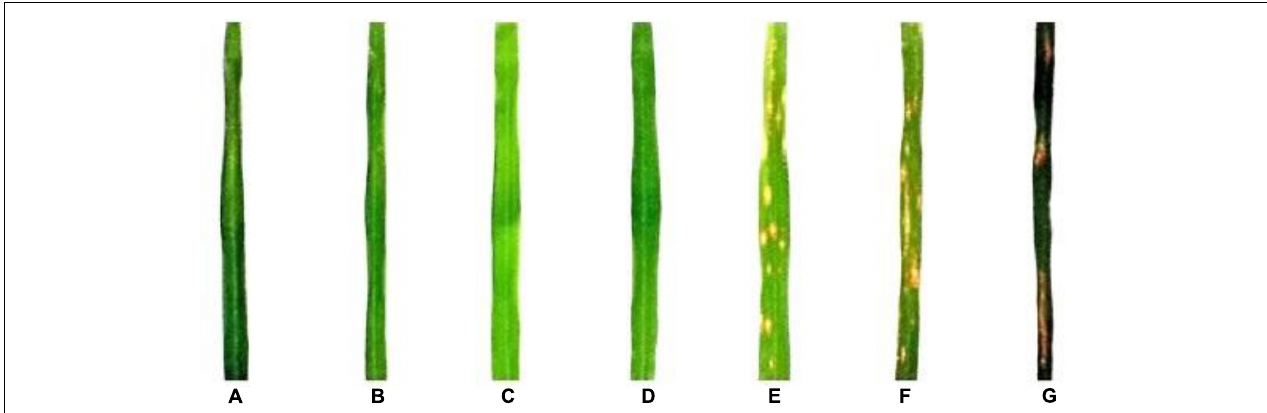
FIGURE 1 | Pathogenicity assay of Pi9 positive rice landraces. (A) , IRBL9-w; (B) , IC450108; (C) , IC449579; (D) , IC347244; (E) , IC449609; (F) , IC449695; (G) ,